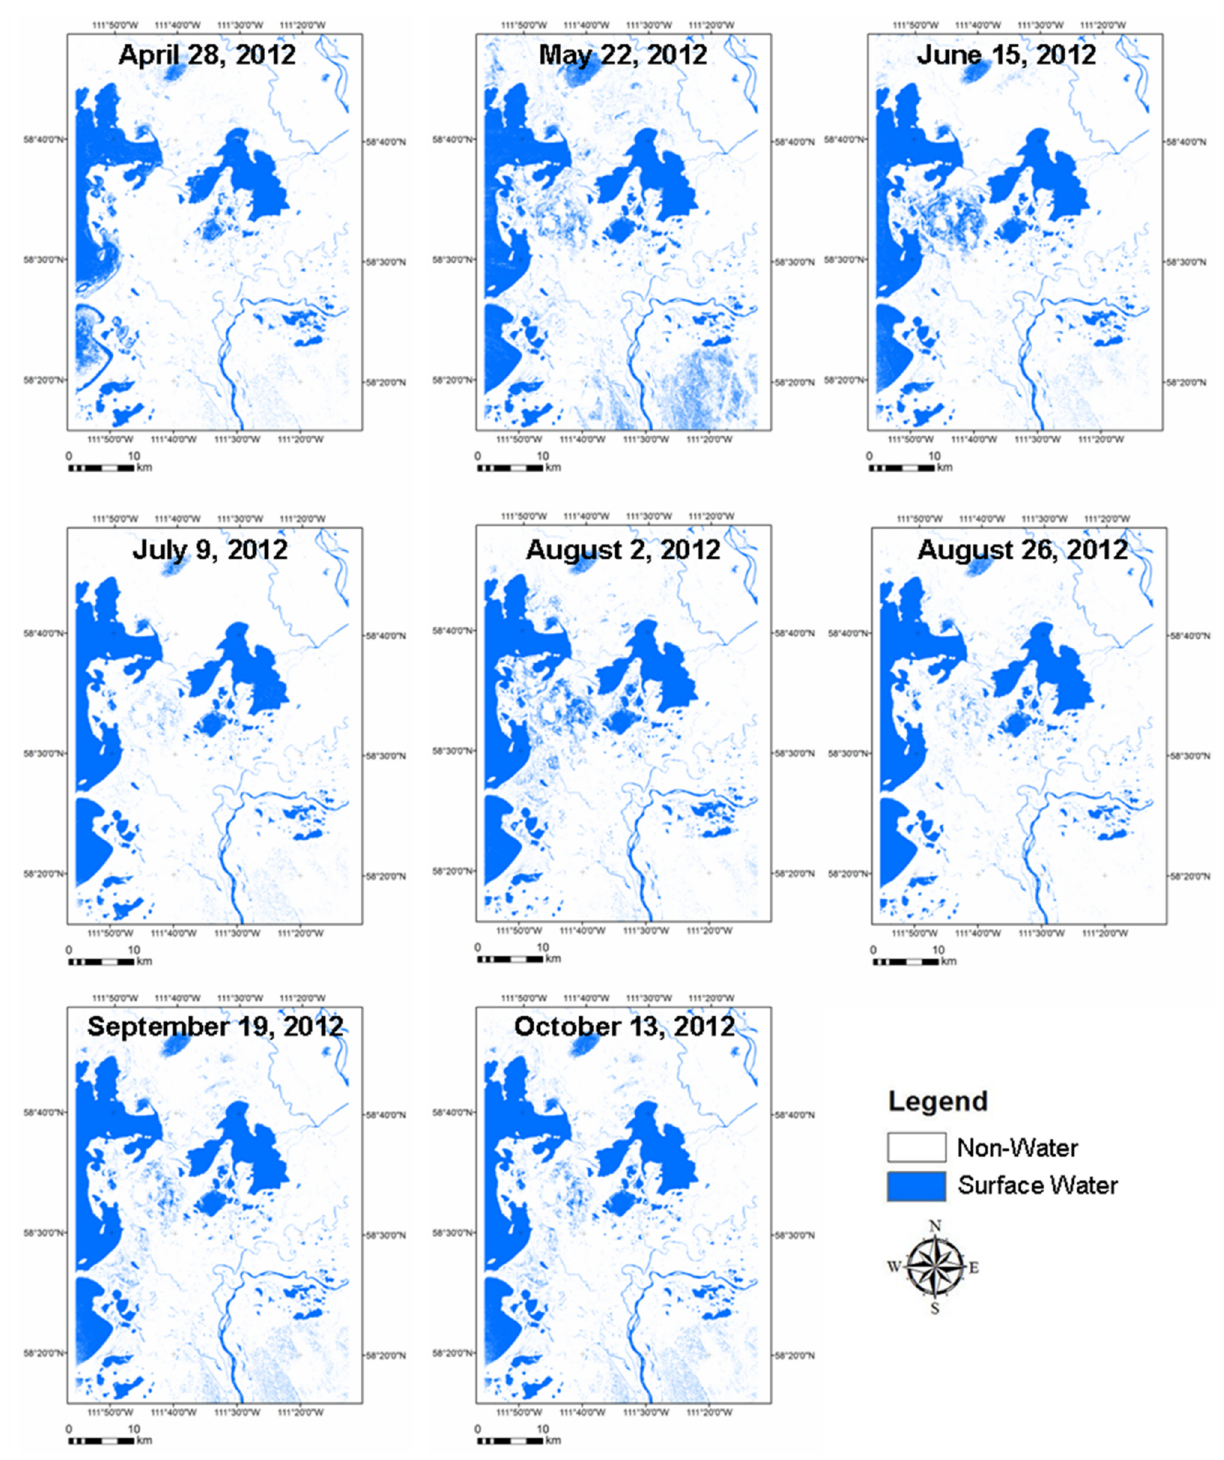
Figure 4. Radar-derived surface water maps from April to August 2012. These images were produced using a thresholding approach and captured the dynamic changes in surface water extent throughout the ice-off